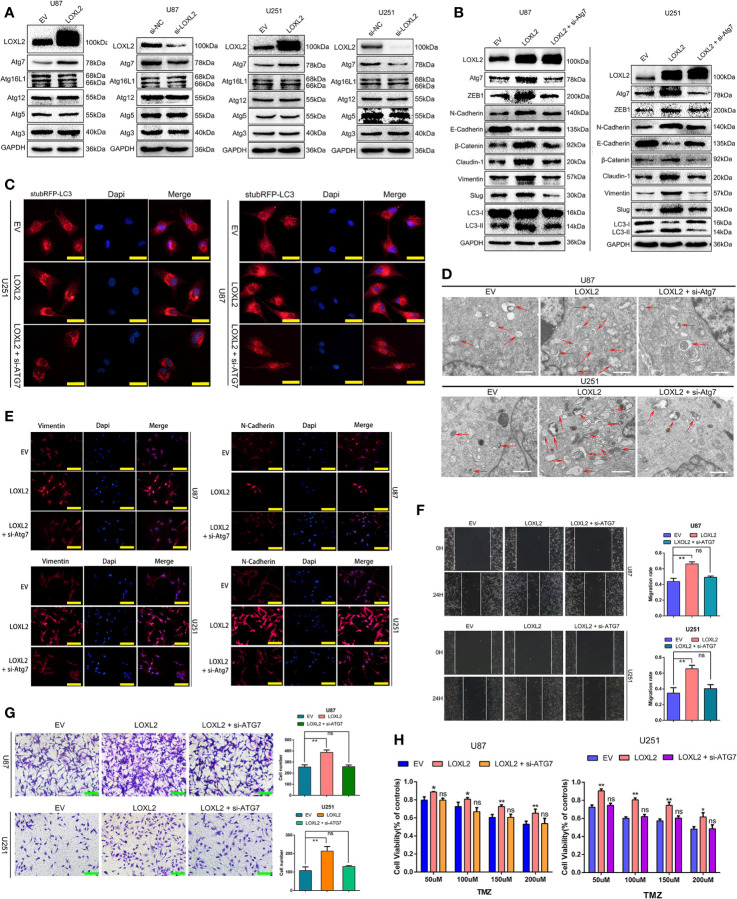
LOXL2 affects autophagy by regulating Atg7 expression. (A) LOXL2 regulated Atg7 expression but not Atg5, Atg3, Atg12, or Atg16L1. (B) Expression of Atg7, EMT-related markers, LC3-I and LC3-II in differently transfected glioma cells. (C) Immunofluorescence of stubRFP-LC3 punctuate localization in glioma cells with EV, LOXL2, and LOXL2 + si-Atg7 treatment; scale bar = 40 µm (D) Autophagy evaluated in glioma cells with EV, LOXL2, and LOXL2 + si-Atg7 treatment using TEM. Red arrows, autophagic structure; scale bar = 1 µm. (E) Immunofluorescence determined the Vimentin and N-cadherin expression in differently transfected glioma cells; scale bar = 100 µm. (F, G) Wound healing (F) and Transwell assays (G) in glioma cells to compare migration and invasion potential with EV, LOXL2, and LOXL2 + si-ATG7 treatment; scale bar = 100 µm. (H) Cell viabilities of control cells or LOXL2-overexpressing cells with or without Atg7-specific siRNA and indicated TMZ doses. *P < 0.05; **P < 0.01, ns: P ≥ 0.05.